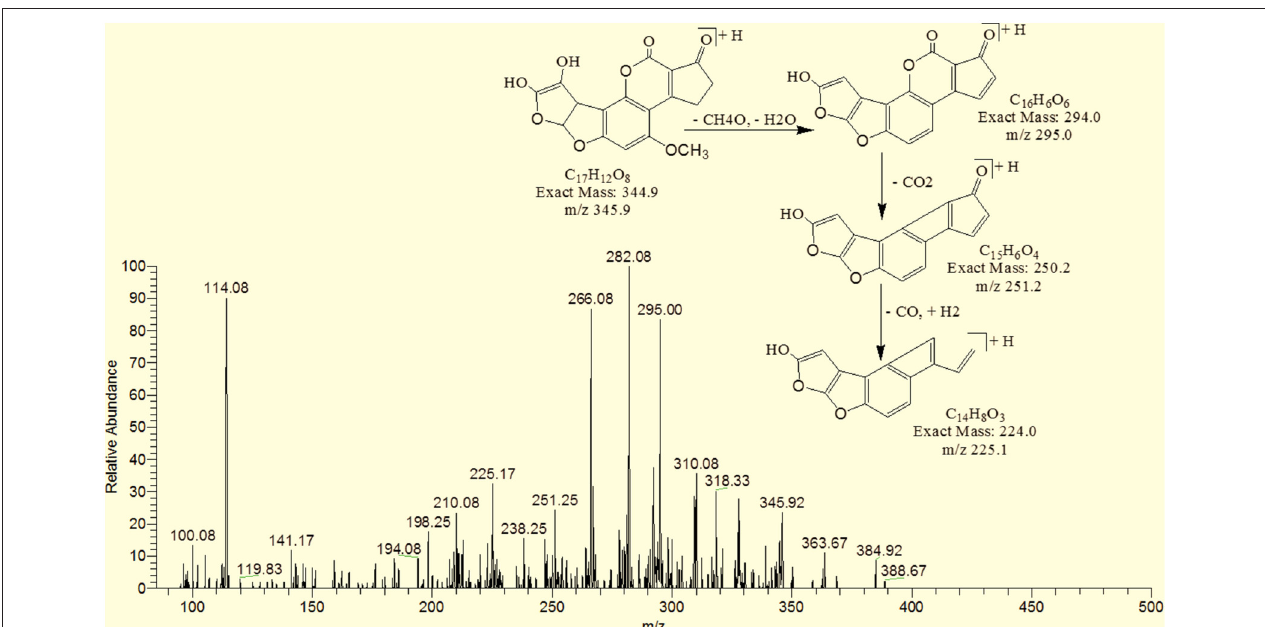
FIGURE 8 | MS/MS spectra and fragmentation pathway of degradation product with 345.92m/z.